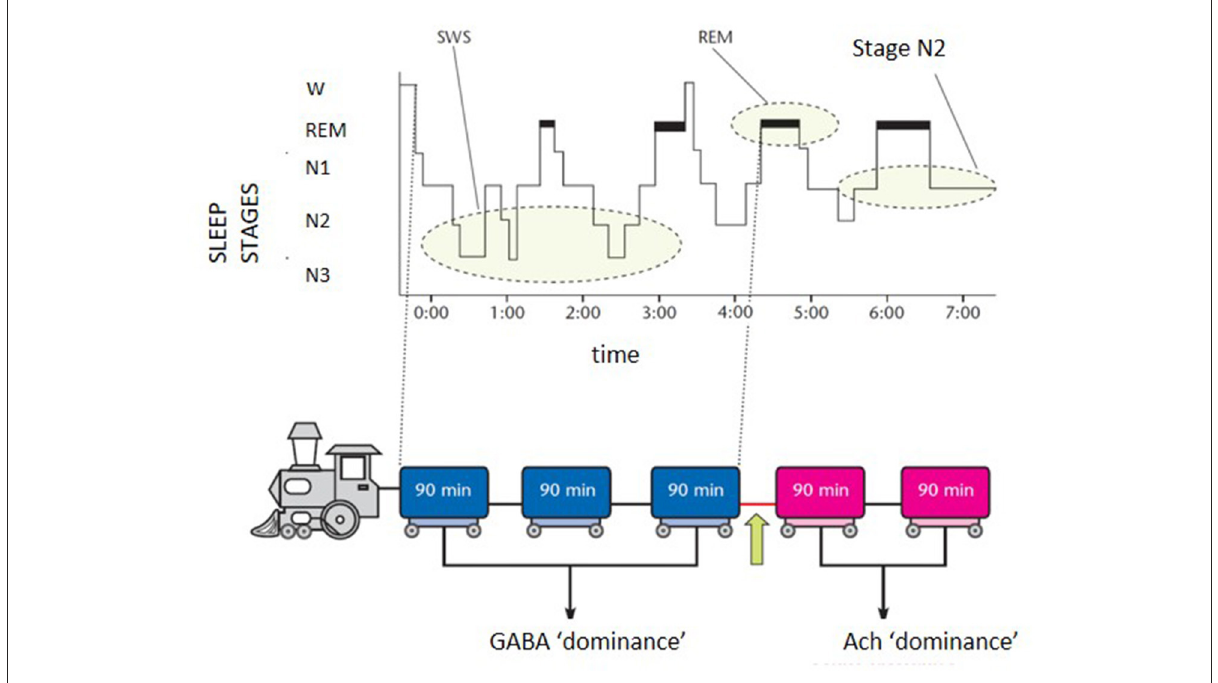
FIGURE1 Schematic representation of the “sleep train”. GABA, gamma-aminobutyrate; Ach,